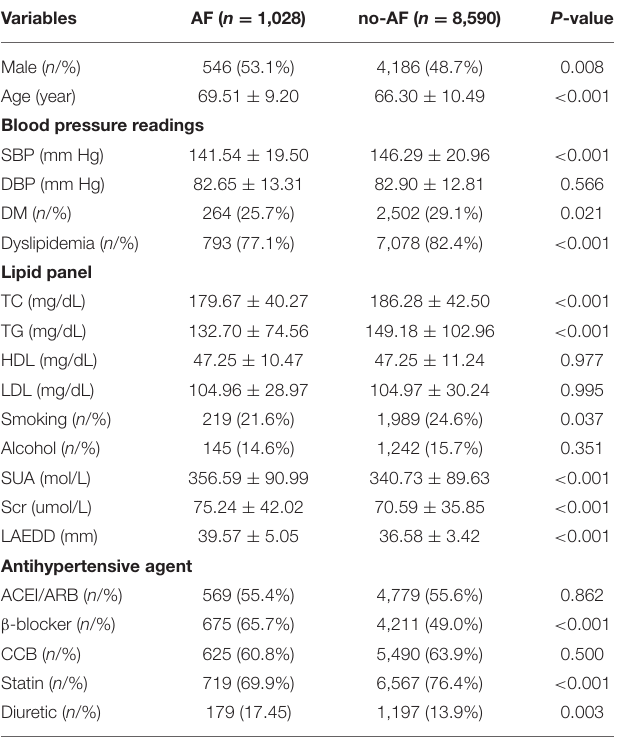
TABLE 1 | Baseline characteristics of the